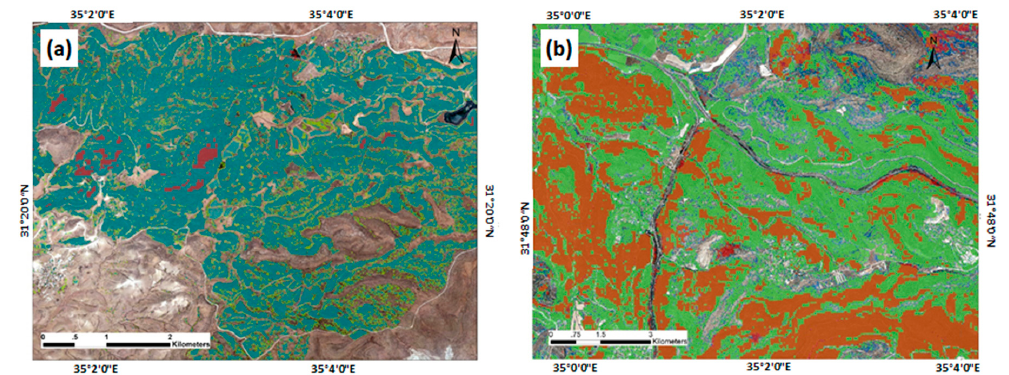
Figure 3. Examples of automatic mapping of woody vegetation in two regions in Israel: ( a ) Yatir forest (200 mm year − 1 ), and ( b ) Judean mountains (500 mm year − 1 ); using the tree cover dataset from Hansen et al. [3] (in red), the minimum 0.2 NDVI threshold (in blue), and our suggested dynamic precipitation-sensitive threshold (in green).